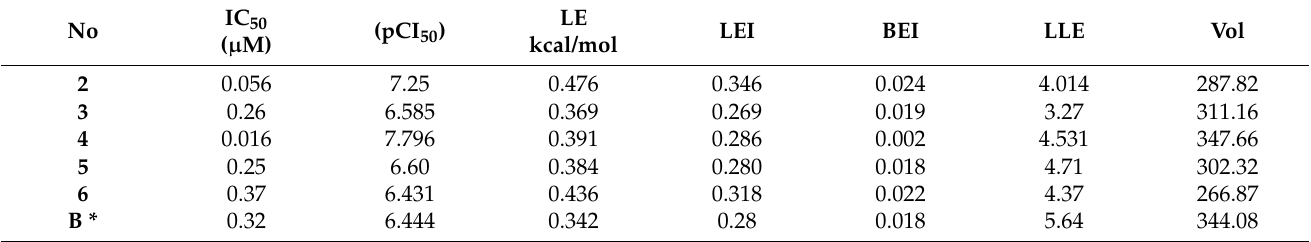
Table 5. LE and LLE of compounds B , 2 – 6 in MDA-MB-31